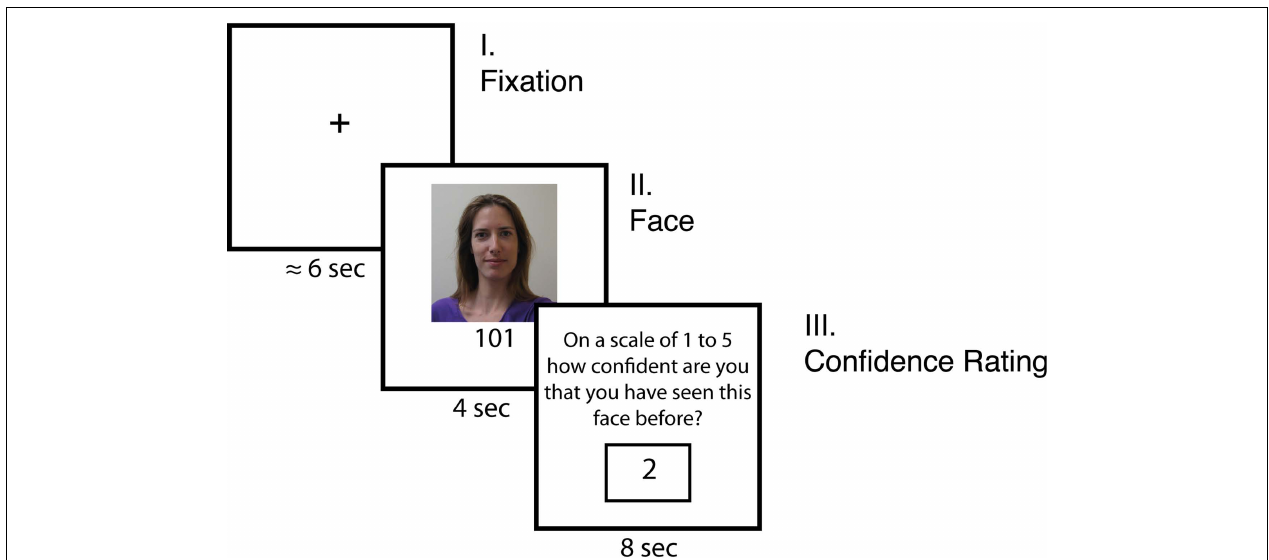
FIGURE 1 | Timeline of memory experiment. Participants fi rst viewed a jittered fi xation that was on average 6 s long before seeing each face. Participants saw 24 photographs of previous partners in the Ultimatum Game and 24 new people for 4 s. Participants were then asked to rate their level of confi dence that the face was either new or old on a 5 point rating